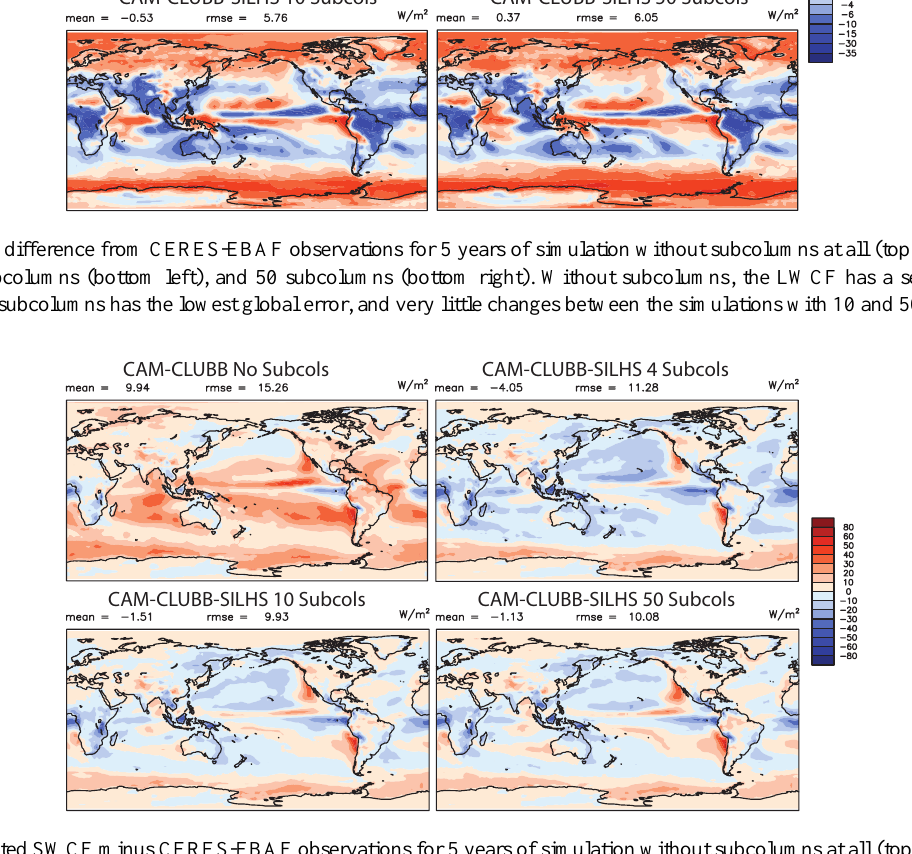
Figure 13. Simulated SWCF minus CERES-EBAF observations for 5 years of simulation without subcolumns at all (top left), 4 subcolumns (top right), 10 subcolumns (bottom left), and 50 subcolumns (bottom right). Without subcolumns, the clouds are too dim. The simulation with 4 subcolumns has brighter clouds than observed, and the simulations with 10 and 50 subcolumns differ little from each